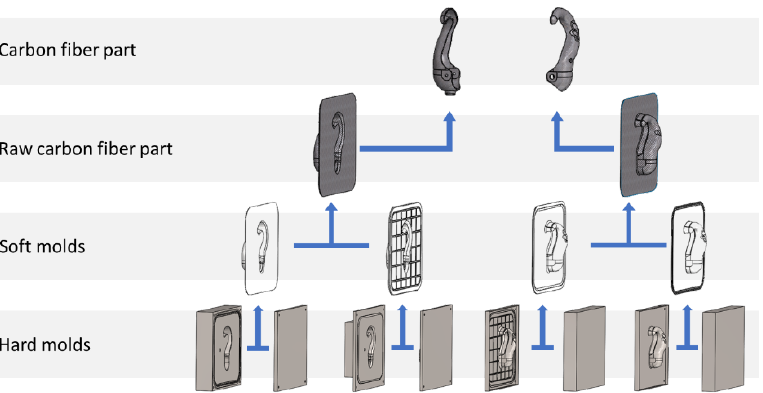
Figure 6. Design of molds to generate carbon fiber parts.